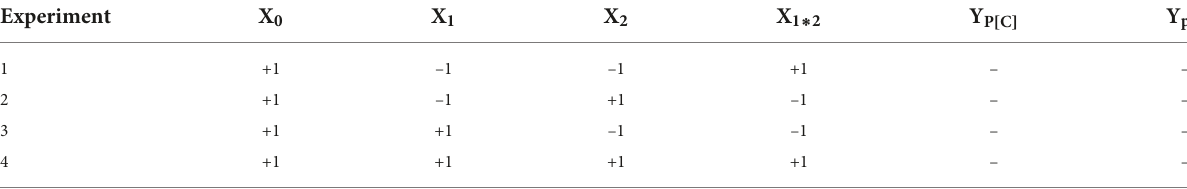
TABLE 2 Experimental design developed to study the effects of factors (X1: RP and X2: TCP) and their interaction (X1*X2) on pH medium and P concentration. Experiment